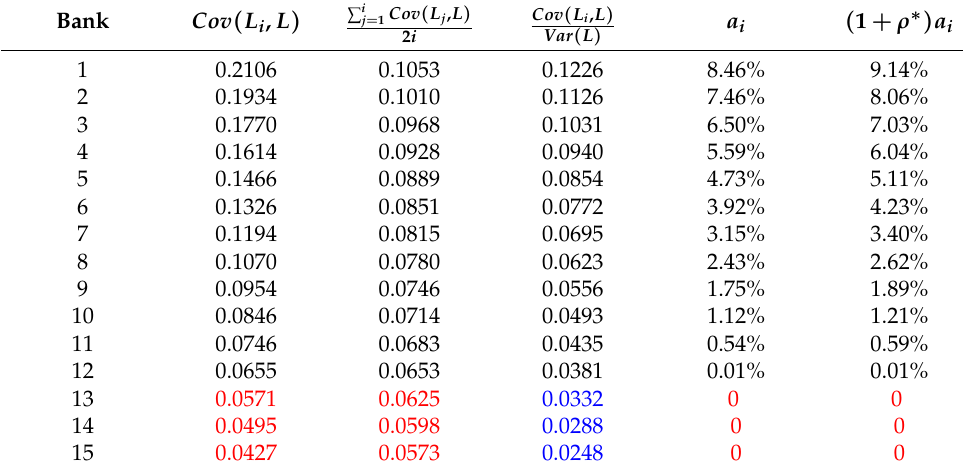
Table 1. This table displays a bank sector with 15 banks and identifies “too-big-to-fail”